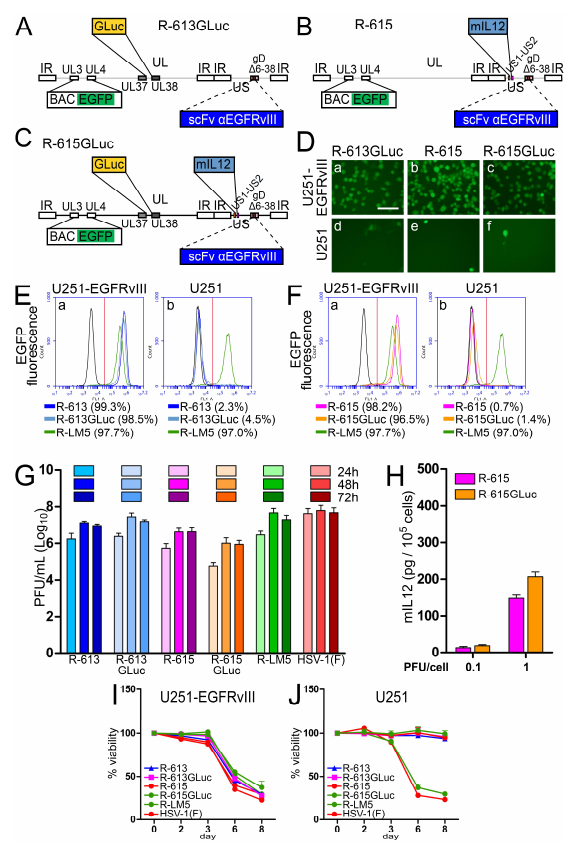
Figure 8. Properties of the EGFRvIII-retargeted recombinants expressing mIL12 and/or GLuc. ( A – C ) Schematic drawings of the genomes of recombinants carrying expression cassettes. pBeloBAC11 and EGFP (BAC EGFP) are inserted between UL3 and UL4 [50]. ( A ) R-613GLuc has the same backbone as